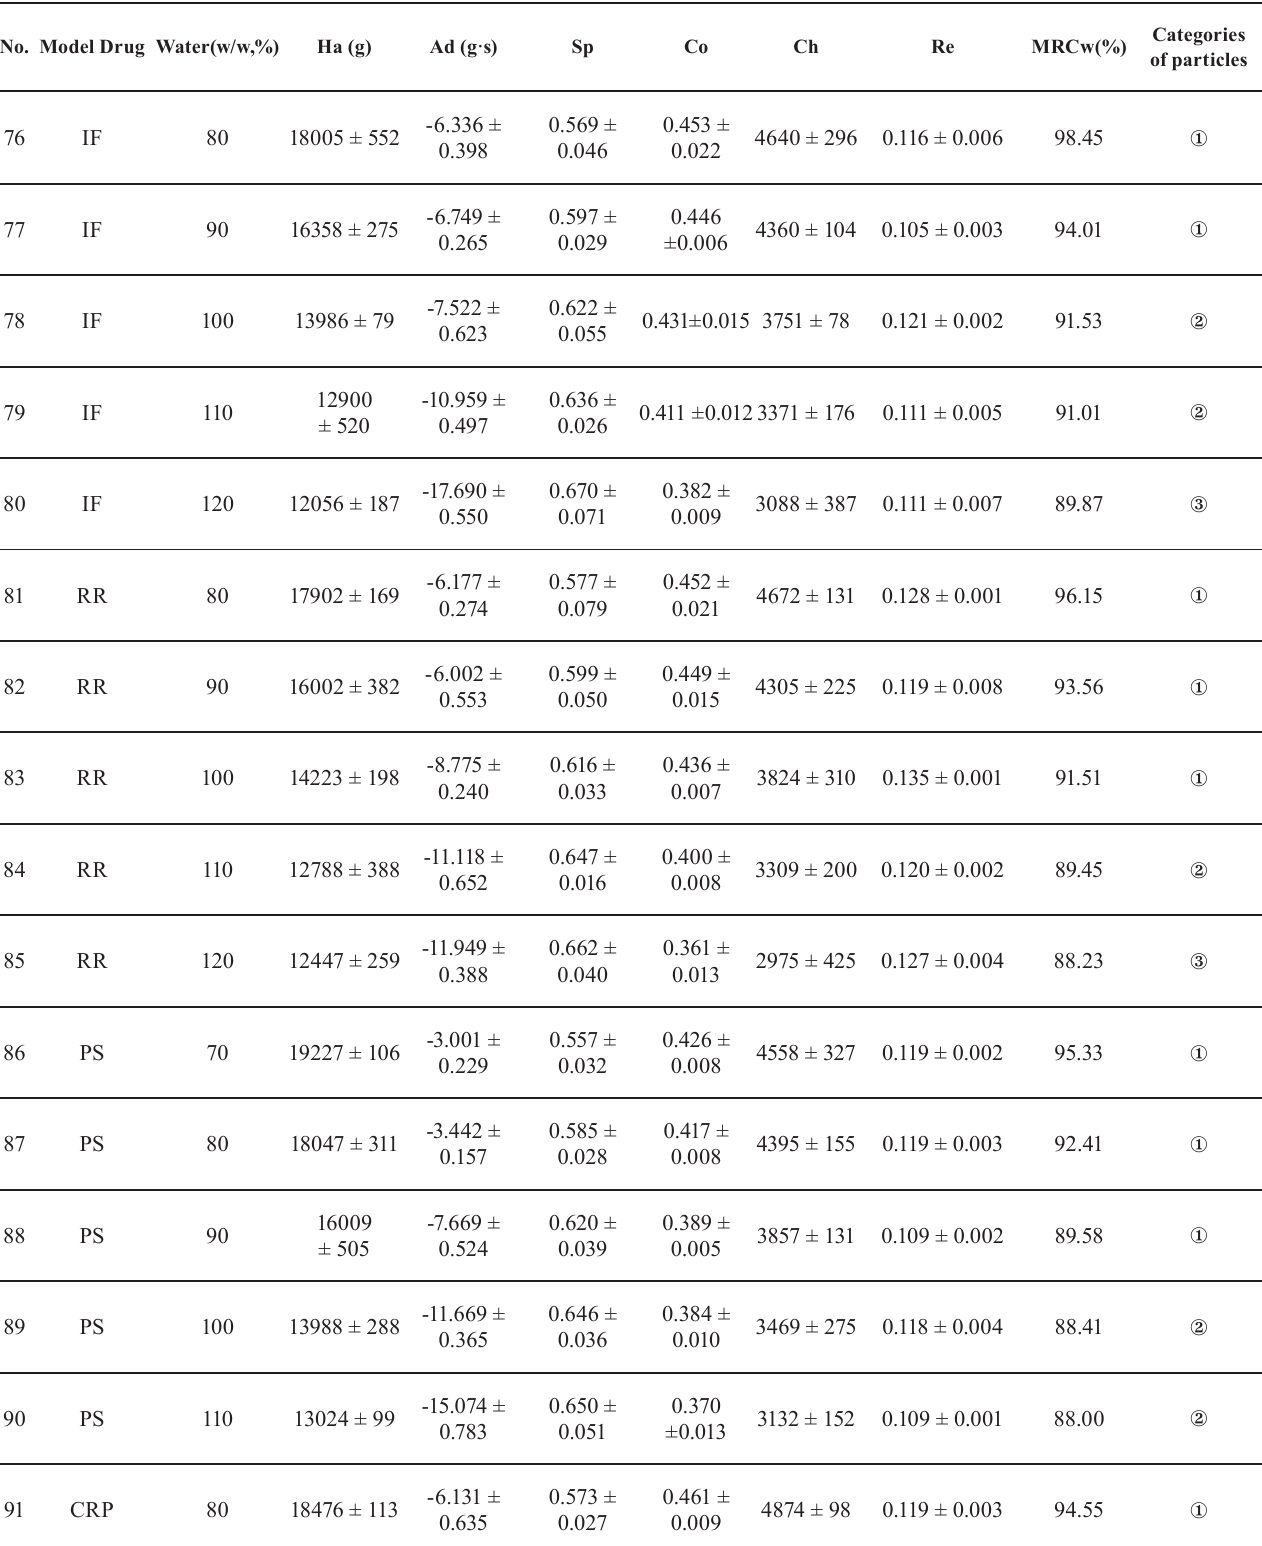
TABLE II – The physical properties of wet masses and categories of pellets from 100 formulations (n=3, x ± s)